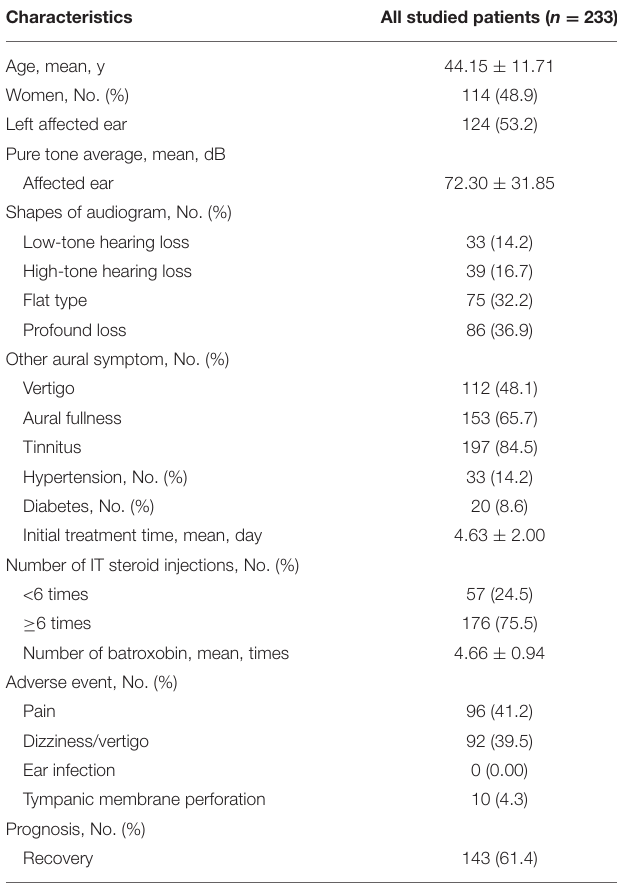
TABLE 1 | Baseline. Hearing and prognosis characteristics of SSNHL